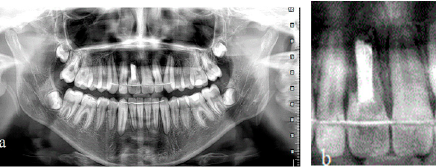
Figure 7. ( a ) Final panoramic radiograph. Fixed retainers for upper and lower arch. Bone healing around 11 was completed. ( b ) Magnified detail from the adjacent panoramic radiograph, presenting severe root resorption of 11 and unfortunately apical root resorption of 12 and 21.